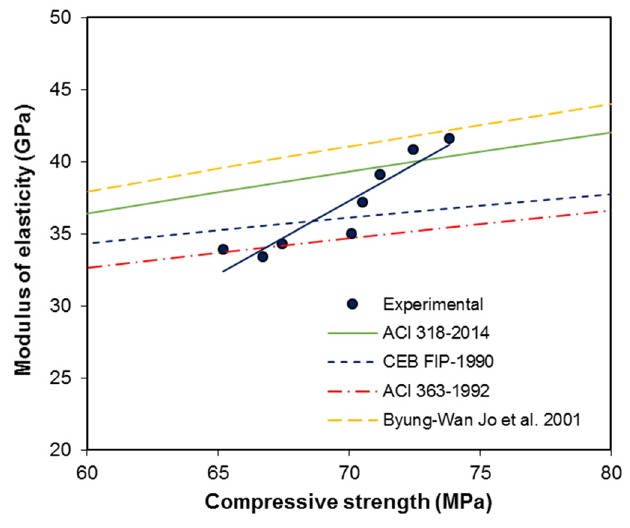
Figure 14. Compressive strength vs. modulus of elasticity of fiber reinforced concrete (FRC).